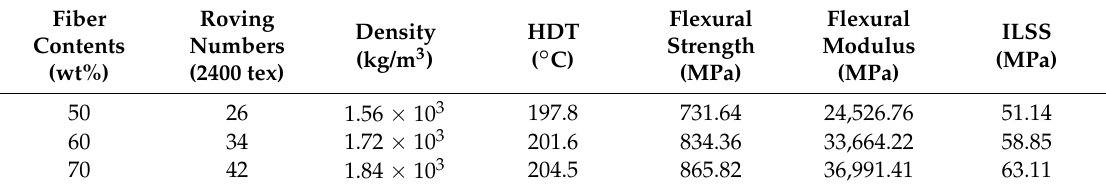
Table 2. The properties of pultruded composites with different fiber